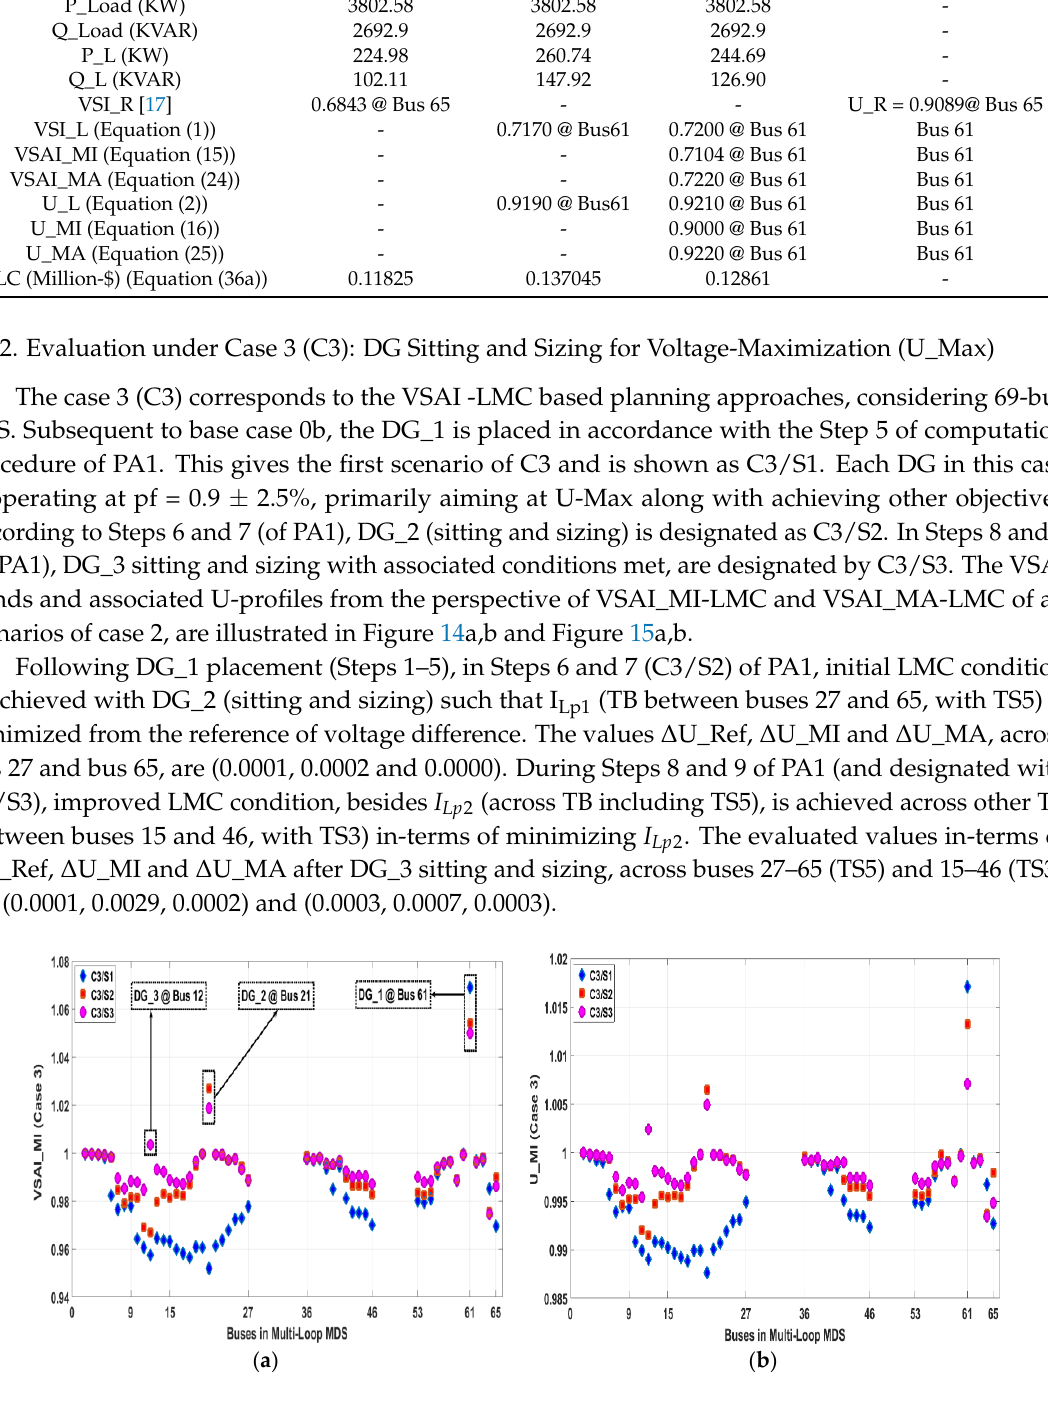
Figure 14. Case 3 for 69-bus MDS (U_Max) ( a ) VSAI trend (based on ideal MDS) for VSAI_MI-LMC; and ( b ) U-profile trend for VSAI_MI-LMC, based planning approach (DG operating @ pf = 0.9 ± 2.5% ).